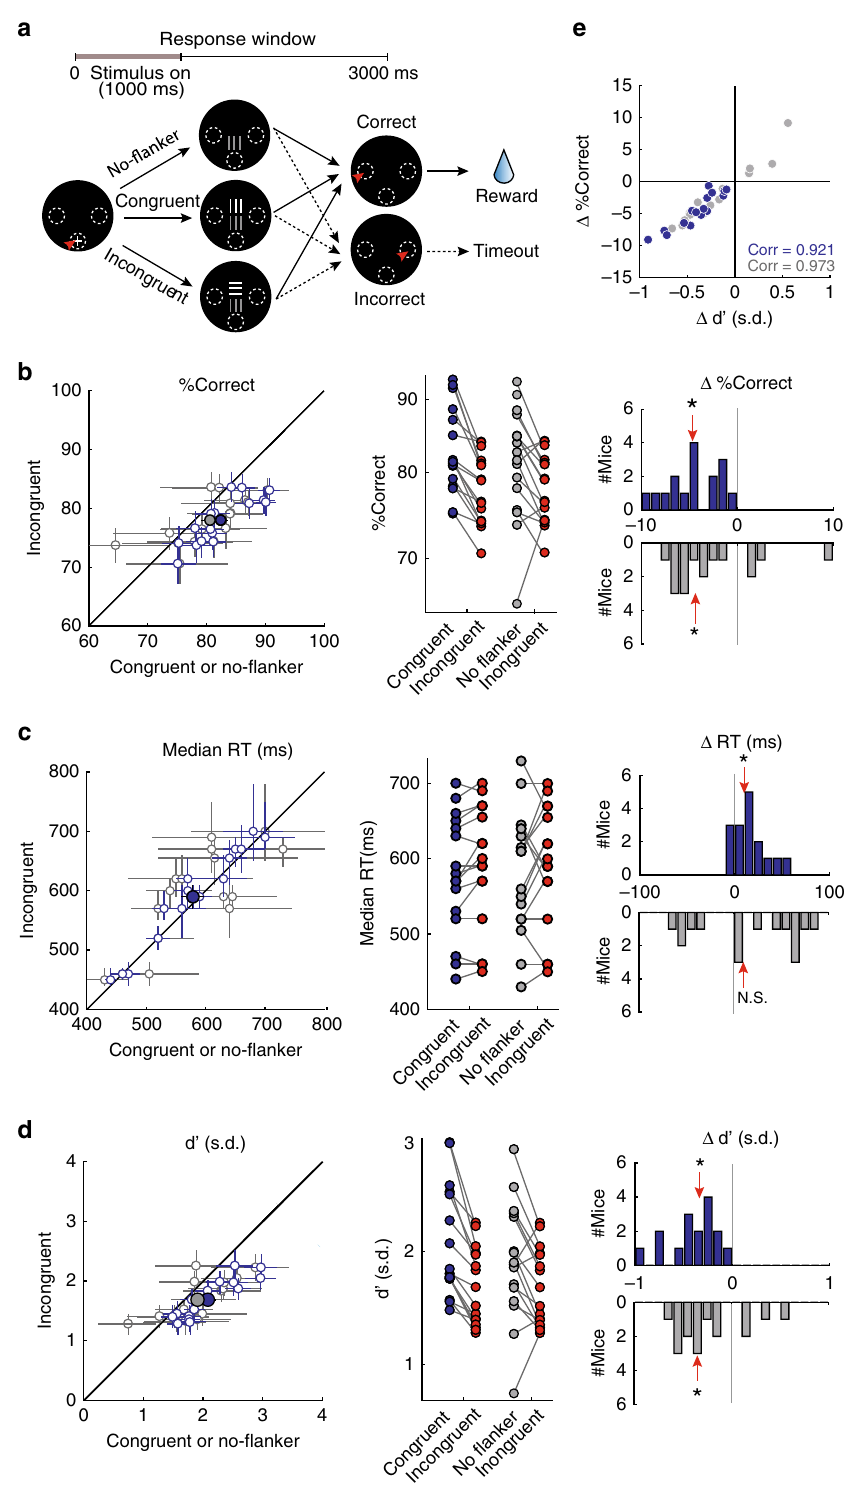
each behavioral